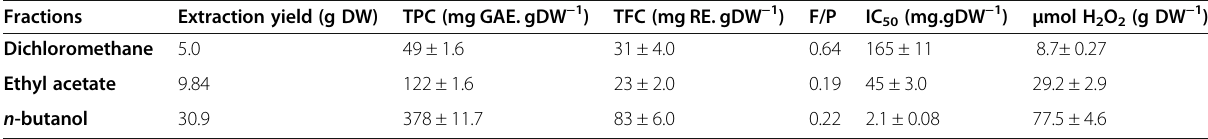
Table 1 Total phenol (TPC) and flavonoid (TFC) contents, antioxidant capacity (IC 50 of DPPH scavenging activity), and hydrogen peroxide production activity for T. indica fractions